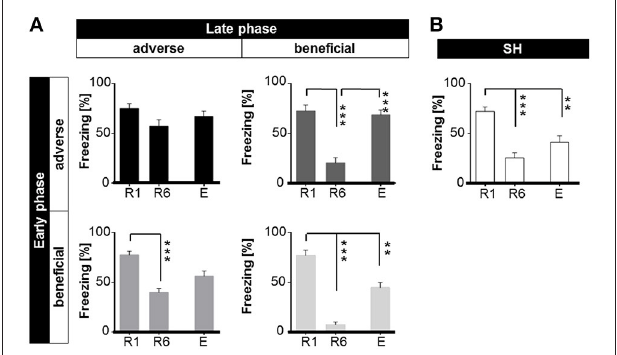
FIGURE 6 | Expression of freezing (% of time) in response to first CS + presentation during retrieval (R1), extinction (R6), and extinction recall (E) dependent on different life histories. (A) Life histories: early and late adversity (AA, top left) mice showed no decline in freezing. Early and late benefit (BB, low right) was significantly accompanied with the capability of extinction learning (R1 to R6) and extinction memory consolidation (R1 to E). Mismatched life history mice (AB and BA, top right and low left) extinguished learned fear, though consolidation of extinction memory (E) was affected. (B) Sham-handled animals significantly extinguished learned fear and consolidated extinction memory. ** p < 0.01; *** p < 0.001; animals per group: n = 15.